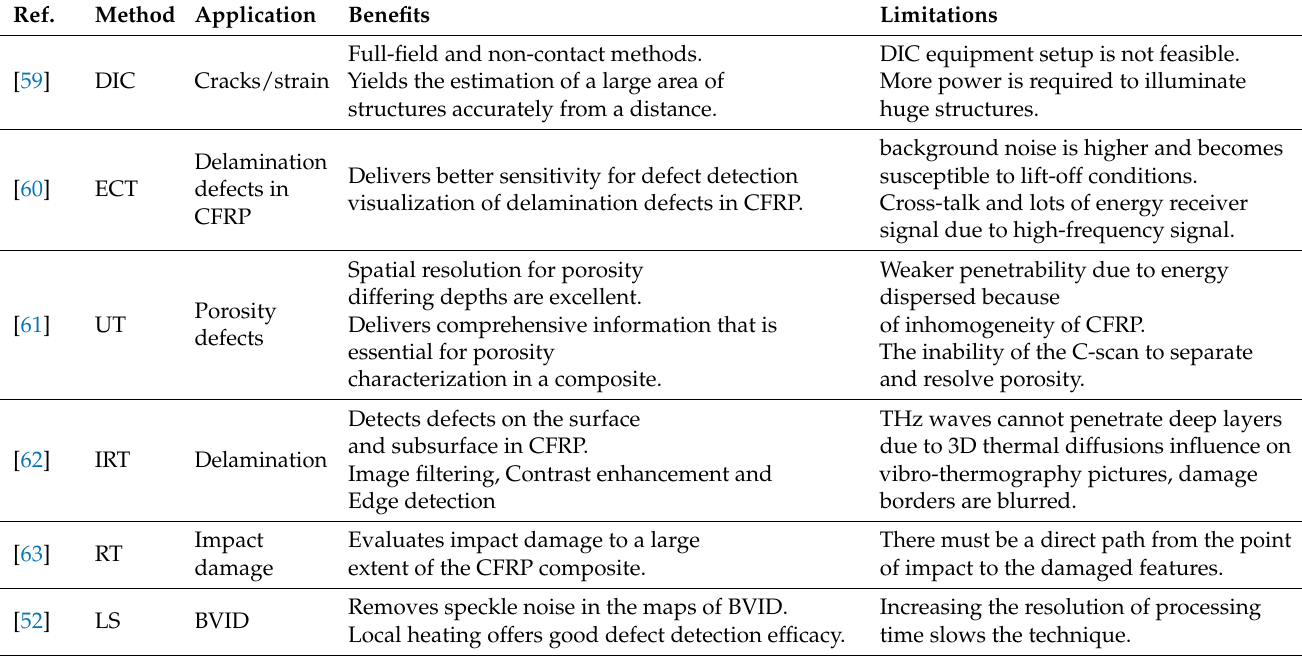
Table 1. Merits and demerits of conventional NDT